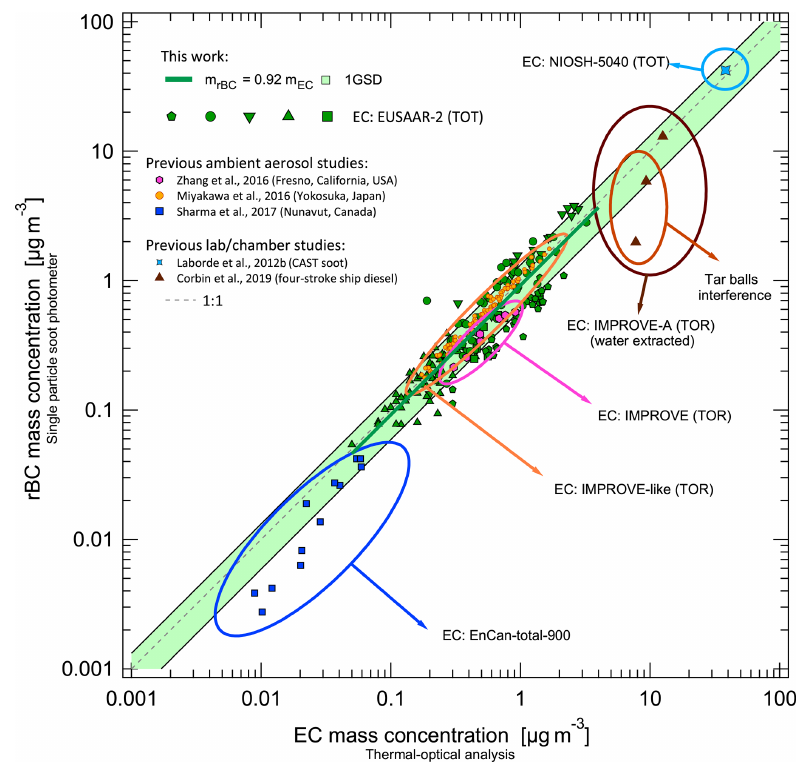
Figure 6. EC mass concentration vs. rBC mass concentration for the datasets studied in this work and other published data.